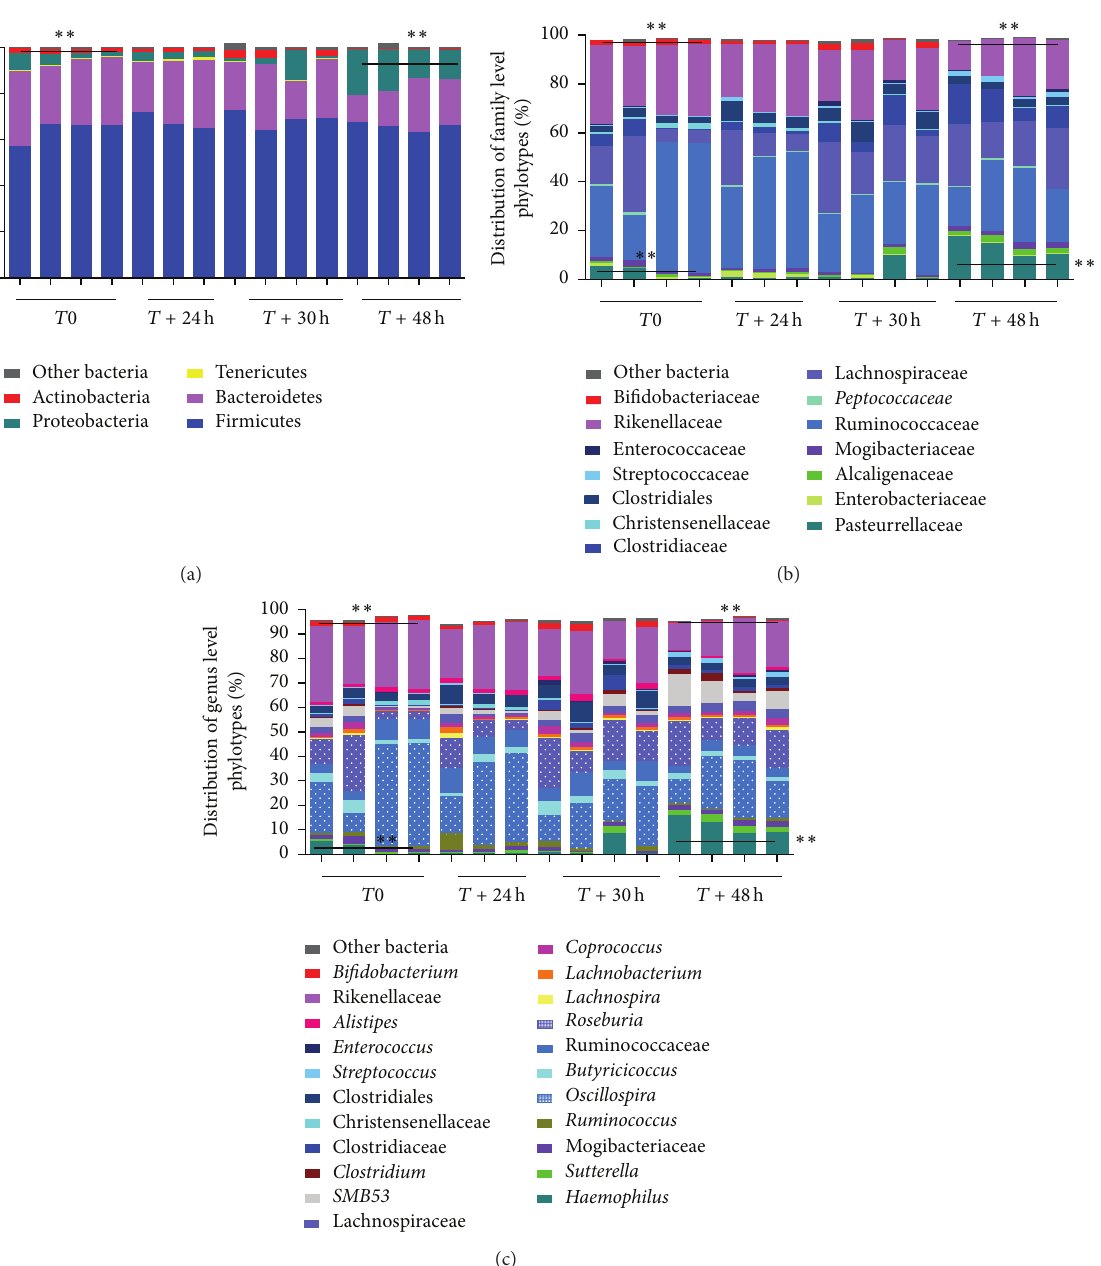
Figure4:Shorttermchangesinthebacterialcommunityprofilingatthephylum(a),family(b),andgenus(c)levelphylotypesoffecalsamples obtained at different time points (0, 24, 30, and 48 h) from a single human subject. For example, a significant increase of Proteobacteria is demonstrated at 48 h compared with 𝑇0 ( ∗∗ 𝑃 < 0.01 ) whereas Actinobacteria are not detectable any more ( ∗∗ 𝑃 < 0.01 ) (a). These changes are confirmed at lower levels of detection, respectively, Pasteurellaceae (b) and Haemophilus (c) and bifidobateriaceae (b) and bifidobacteria (c) ( ∗∗ 𝑃 < 0.01 ). ∗ Mann-Whitney test, 𝑛 = 4 samples/time